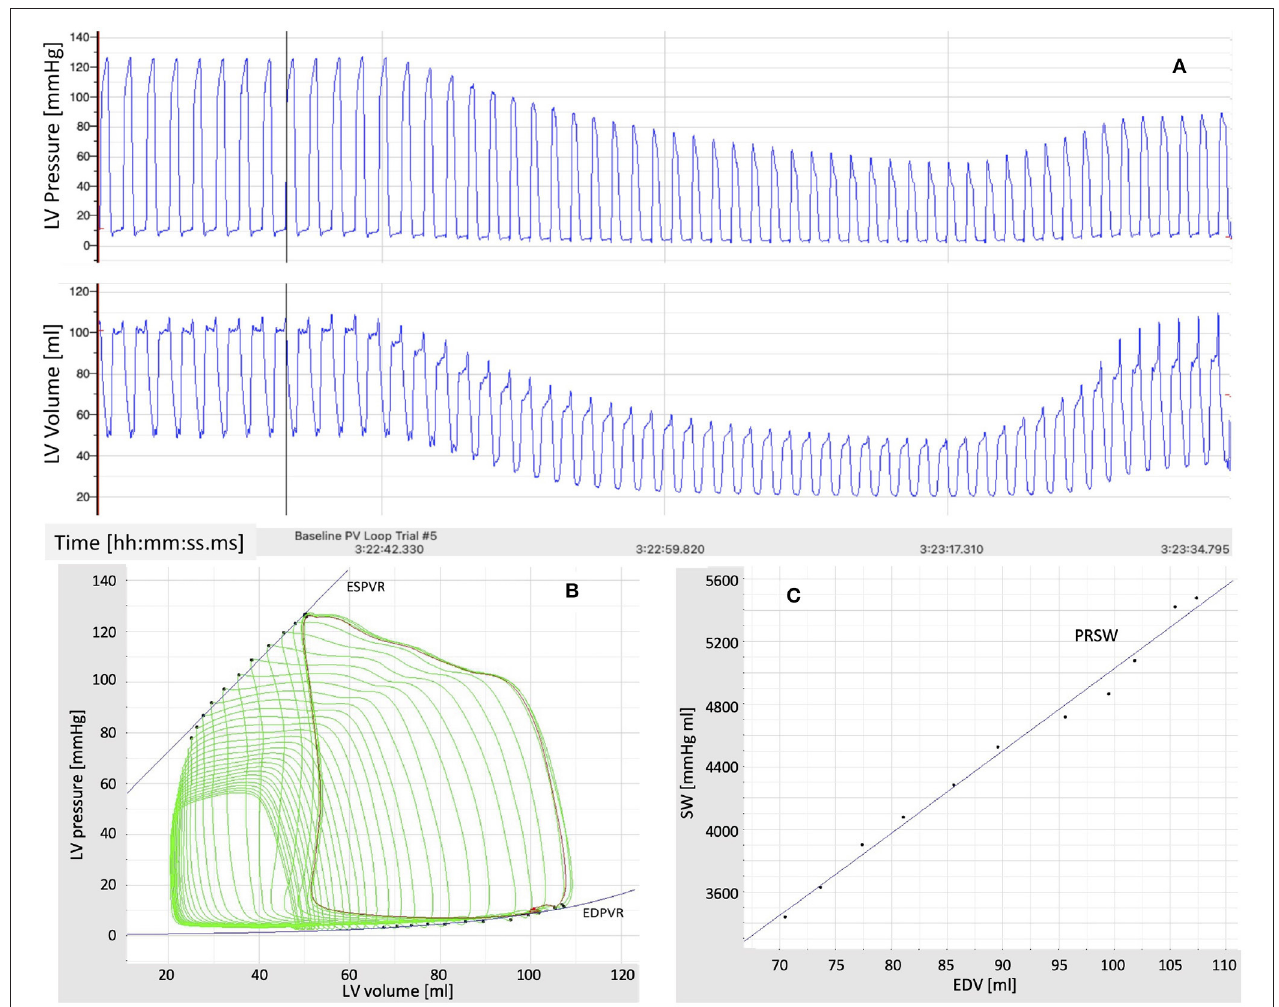
FIGURE 2 | (A) Time recordings of pressure and volume in the left ventricle (LV) under conditions of reducing pre-load, achieved through transient occlusion of the inferior vena cava via inflation of a balloon catheter. (B) Pressure-Volume (P-V) loops in the left ventricle (LV) under conditions of reducing pre-load. The end-systolic and end-diastolic P-V relationships (ESPVR and EDPVR) are also shown. (C) Relationship between stroke work (SW) and end-diastolic volume (EDV) under conditions of reducing pre-load. The slope of the line approximating the SW-EDV relationship is the pre-load recruitable stroke work (PRSW) .